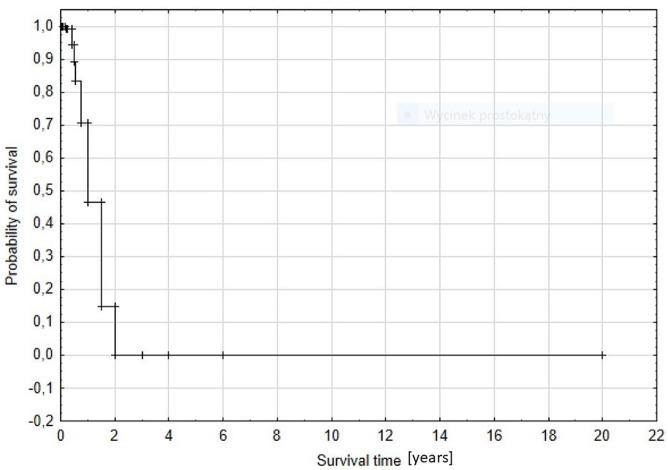
Survival analysis from Cox proportional model, showing the probability of survival depending on time.